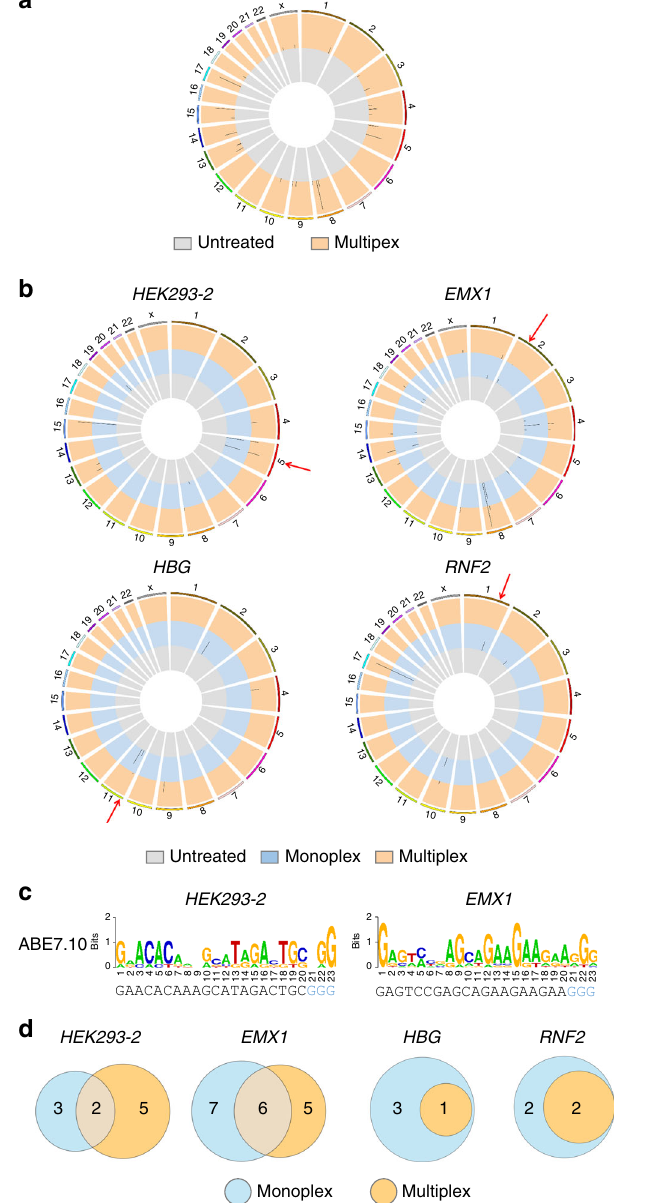
Fig. 3 Using multiplex EndoV-seq to pro fi le off-target effects of ABE. a Human genomic DNA (10 μ g) was treated with a mixture of 300 nM ABE7.10 and six gRNAs (200 nM each) ( HEK293-2 , EMX1 , FANCF , HBB-28 (T > C) , RNF2 and HBG ) for 8 h and then with EndoV (8 U) for 3 h. The treated gnomic DNA was subsequently sequenced with ~30 – 40-fold coverage and genome-wide cleavage scores calculated. Sites with cleavage score of >2.5 are plotted here. Orange, genomic DNA treated with ABE7.10 and multiplex gRNAs. Gray, untreated genomic DNA. b Genome-wide cleavage scores (cutoff > 2.5) of untreated (gray), monoplex EndoV-seq (blue), and multiplex EndoV-seq (orange) for the indicated gRNAs are plotted. Red arrows, on-target sites. c Sequence logos (by WebLogo) of multiplex EndoV-seq captured off-target (DNA cleavage scores of >2.5) and on-target sites. d A comparison of monoplex vs. multiplex EndoV-seq captured off-target sites (DNA cleavage scores of >2.5, on-target sites not